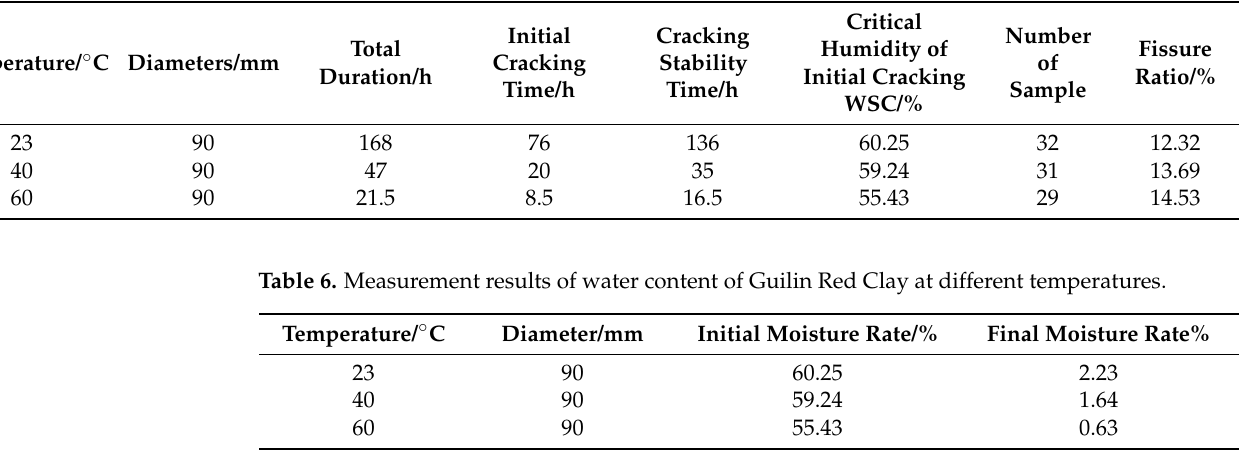
Table 5. Measurement results of relevant crack geometric parameters of Guilin Red Clay at different temperatures.